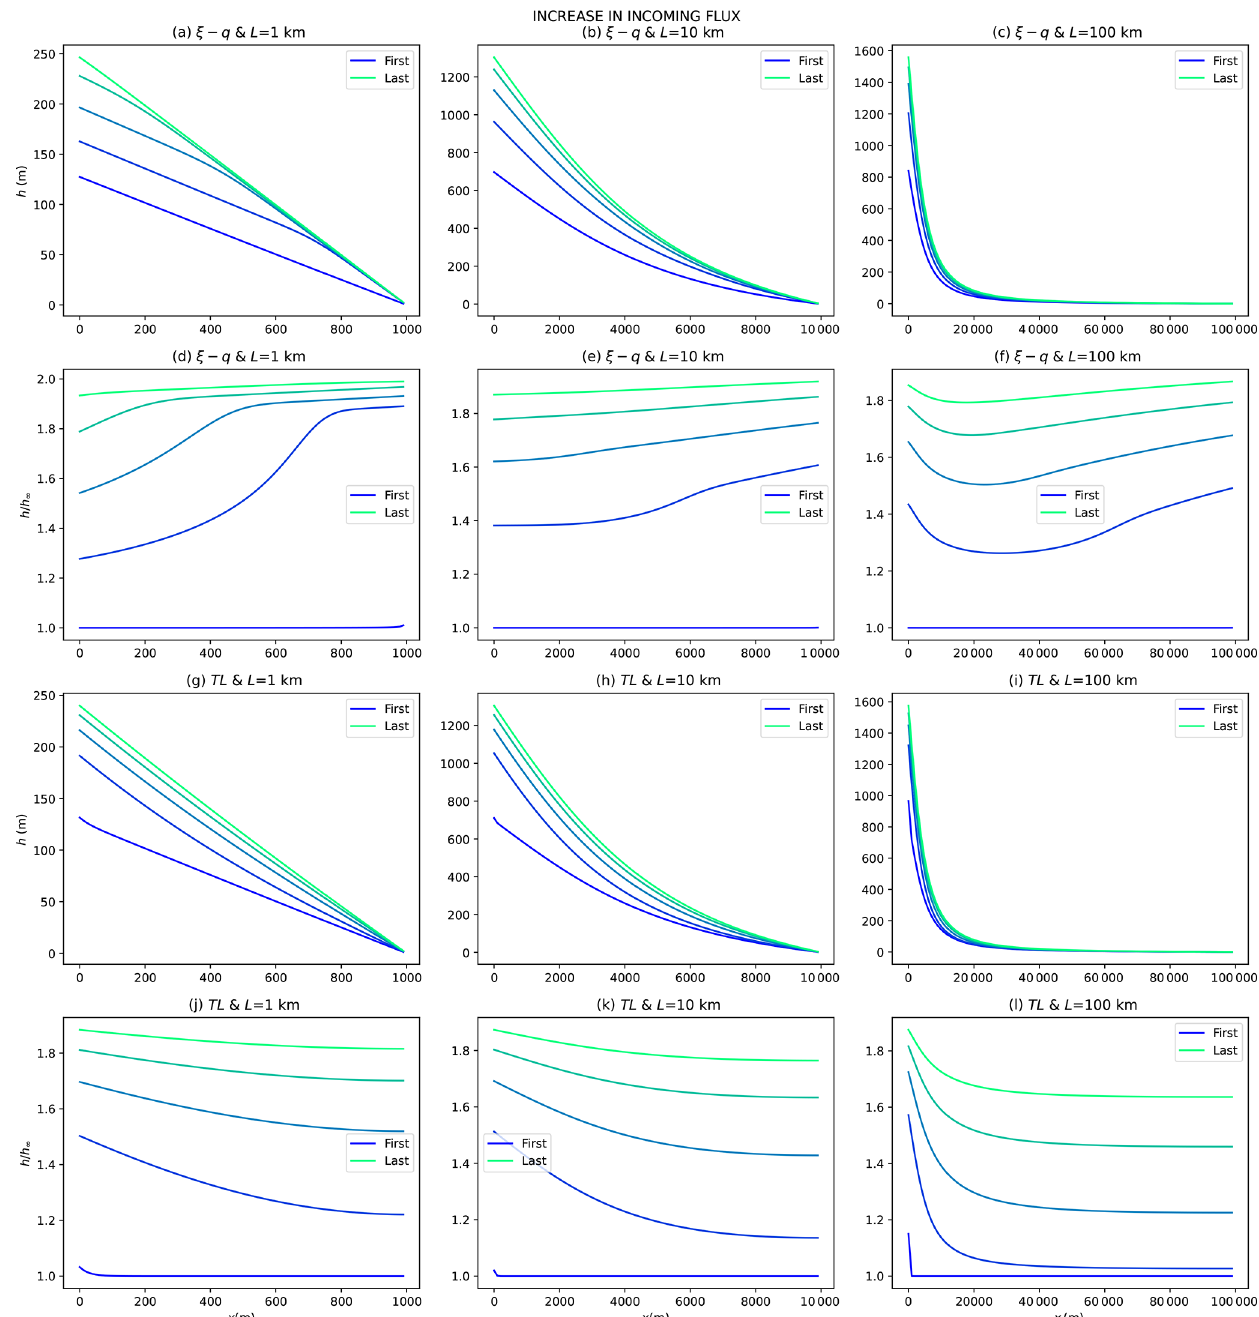
Figure 9. Evolution of the surface topography following an increase in incoming sediment flux by a factor of 2. The ξ – q solution is used in the top six panels, and the TL solution is used in the bottom six panels. Panels (d) to (f) contain the same information as panels (a) to (c) but using the topographic elevation normalized by its final, steady-state value. The same applies for panels (j) to (l) with respect to panels (g) to (i)